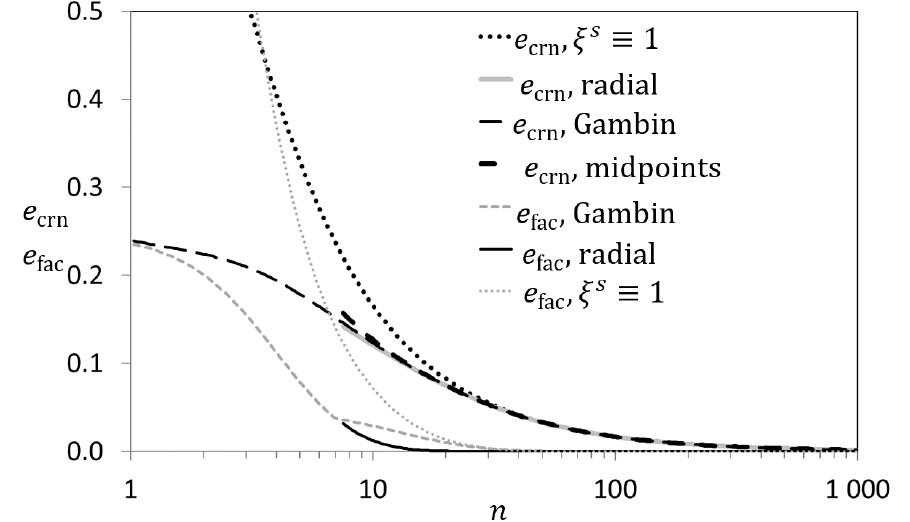
Figure 6. The average error at the corners and at the facet midpoints as a function of n , for the case of bcc with { 110 }(cid:104) 111 (cid:105) and { 211 }(cid:104) 111 (cid:105) slip systems with τ regularizations according to Gambin, fitted to the midpoints, fitted radially or simply by ξ s ≡ 1 are shown.